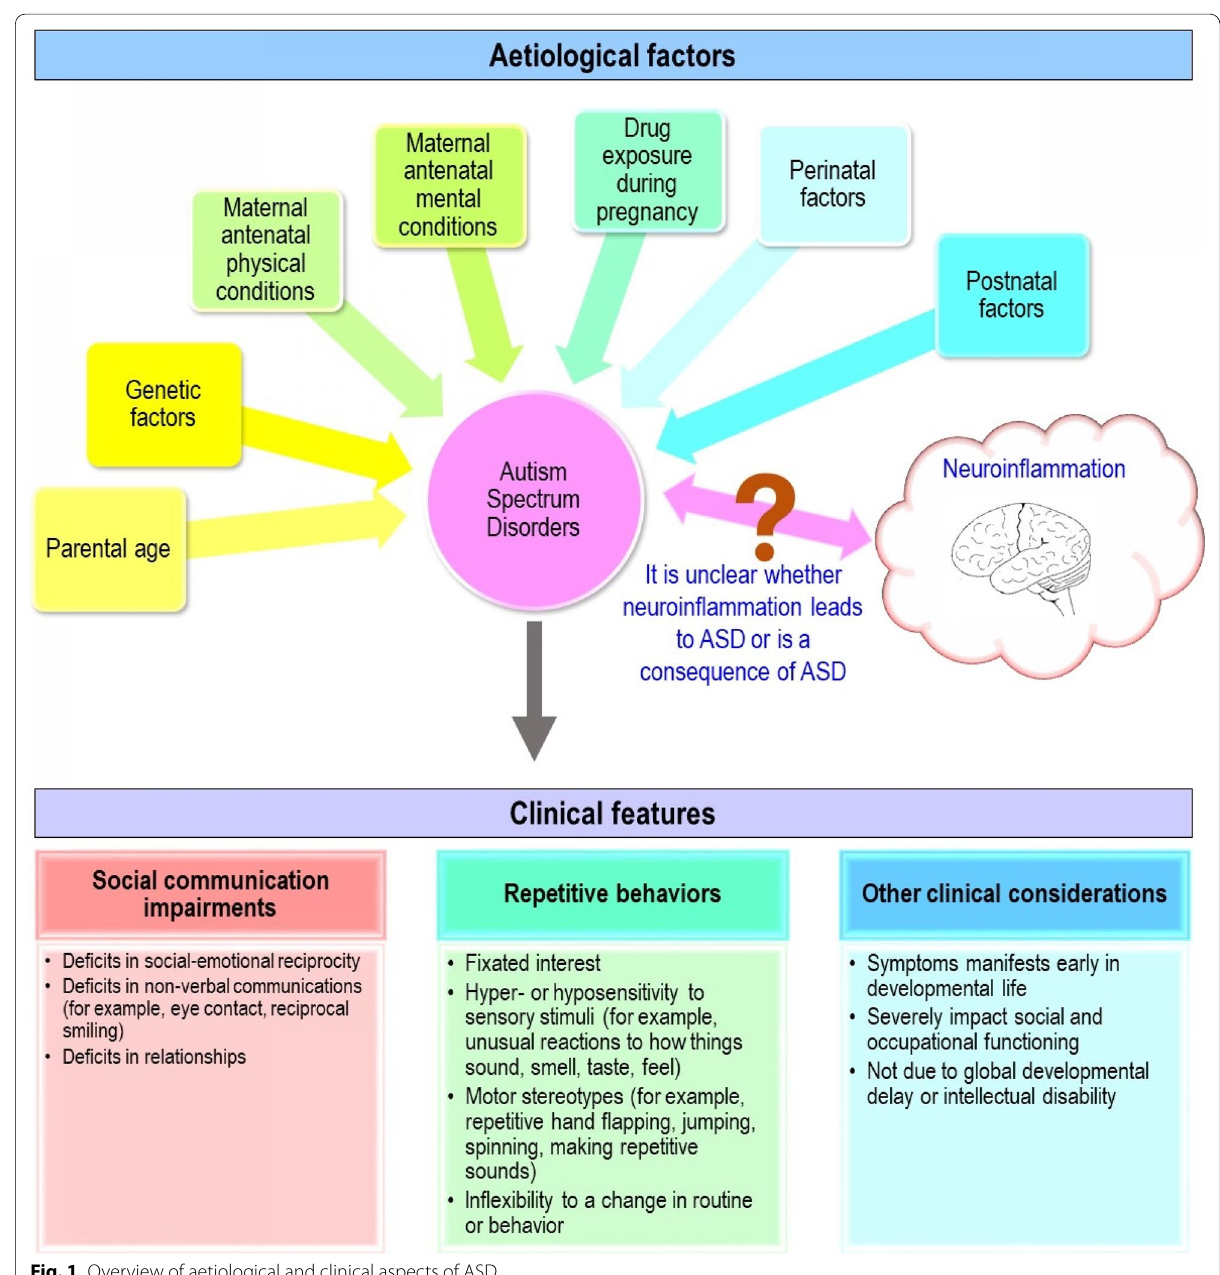
Fig. 1 Overview of aetiological and clinical aspects of